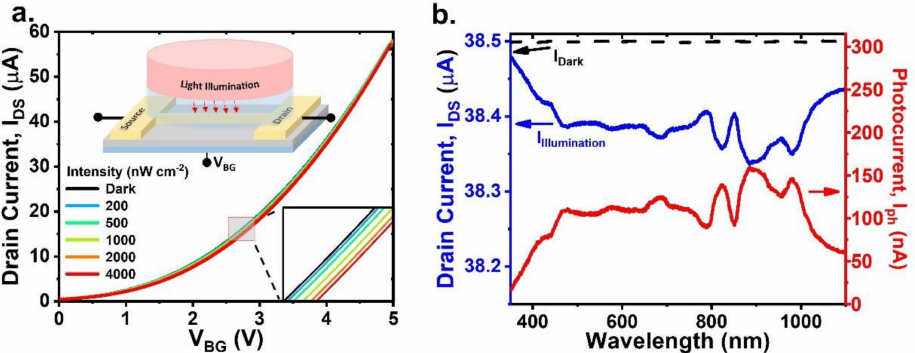
Figure 4. ( a ). I DS –V BG of an opto-FET device with V DS = 0.5 V, λ = 450 nm in the dark (black) and under light illumination of 200 (blue), 500 (green), 1000 (light green), 2000 (orange) and 4000 (red) in unit of nW cm − 2 . and ( b ) the photo-response of the device captured under illumination of the wavelength ranging between 300 nm and 1100 nm. The dark current (dashed black), illumination current (blue) and photocurrent (red). The spectrum is taken with V DS = 0.5 V, V BG = 4 V and intensity is 500 nW cm − 2 . Inset in ( a ), the schematic diagram of the opto-FET under light